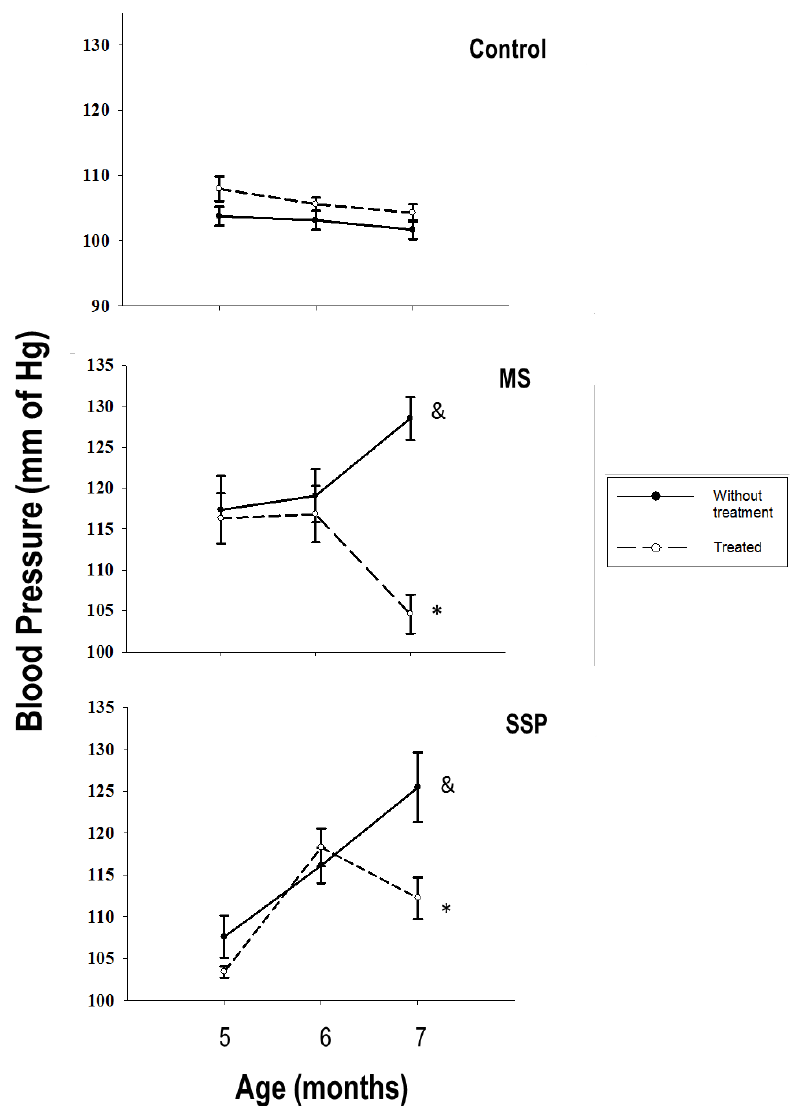
Figure 1. Reversion by treatment for 1 month (from 6 to 7 months of age) with resveratrol (RSV)/quercetin (QSC) of the elevation in blood pressure at 7 months of age caused by exposure to sucrose during the short- (SSP) and long- (MS) term sucrose administration. Data represent the mean ± SEM for six different rats from each group. & p < 0.05 against C group without treatment; * p < 0.05 against respective group without treatment.